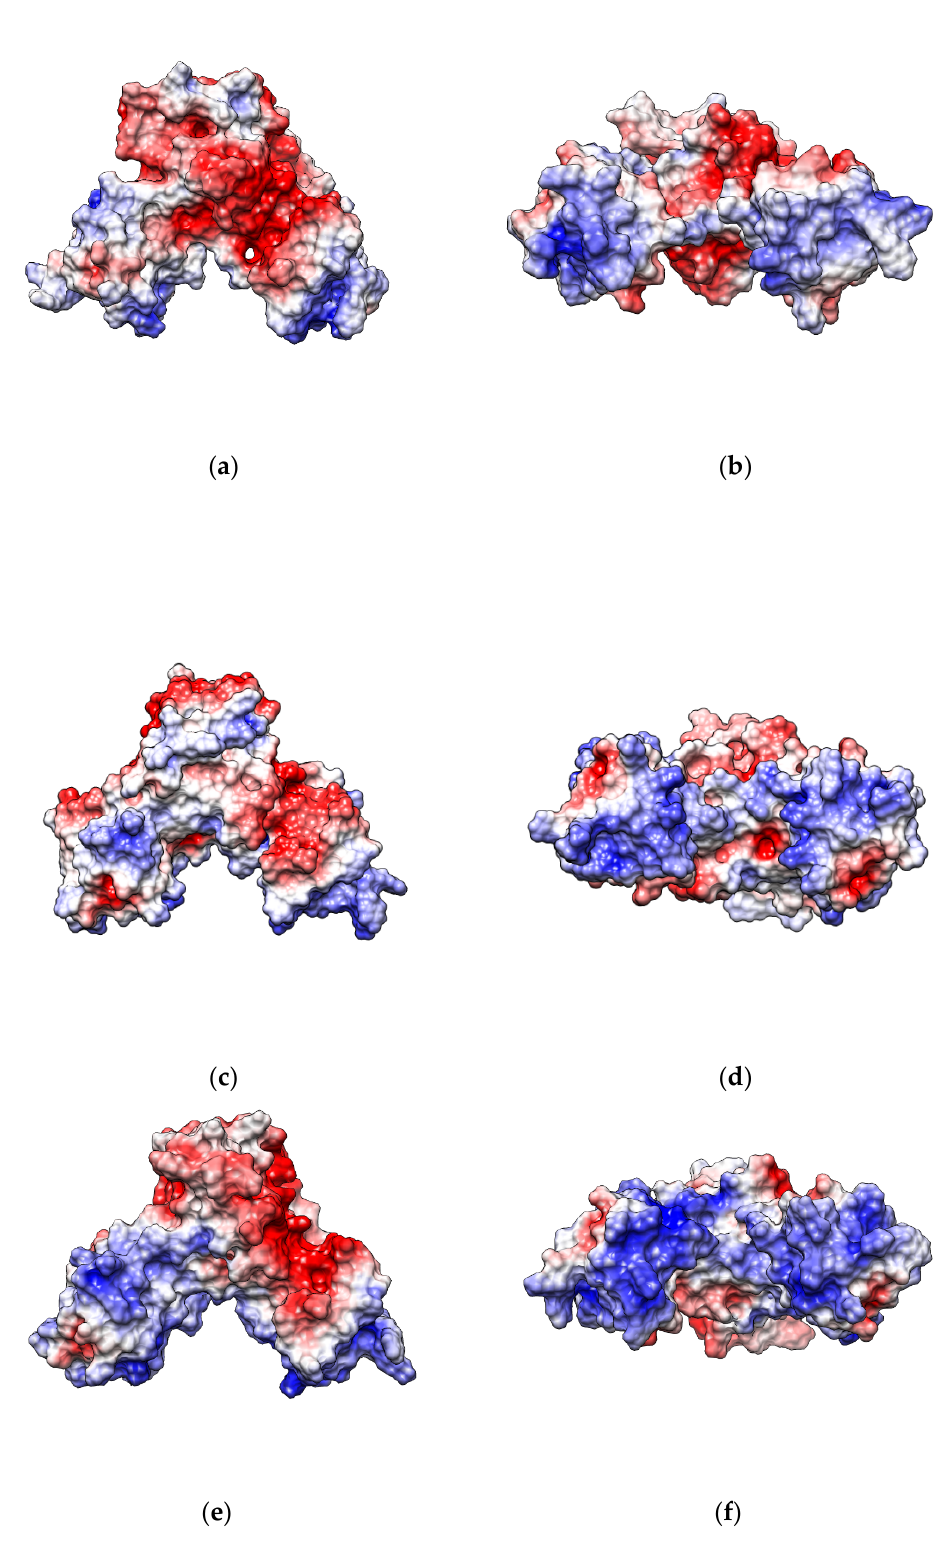
Figure 7. The electrostatic potential on the surface of the MntR protein calculated on the structure which represents the centroid of the most-populated cluster for the simulations of the apo- ( a , b ), D8C-E99C mutant ( c , d ) and Mn 2+ -bound systems ( e , f ). The systems are shown from the front ( a , c , e ) and bottom ( b , d , f ). The latter perspective highlights the DNA-binding domain.